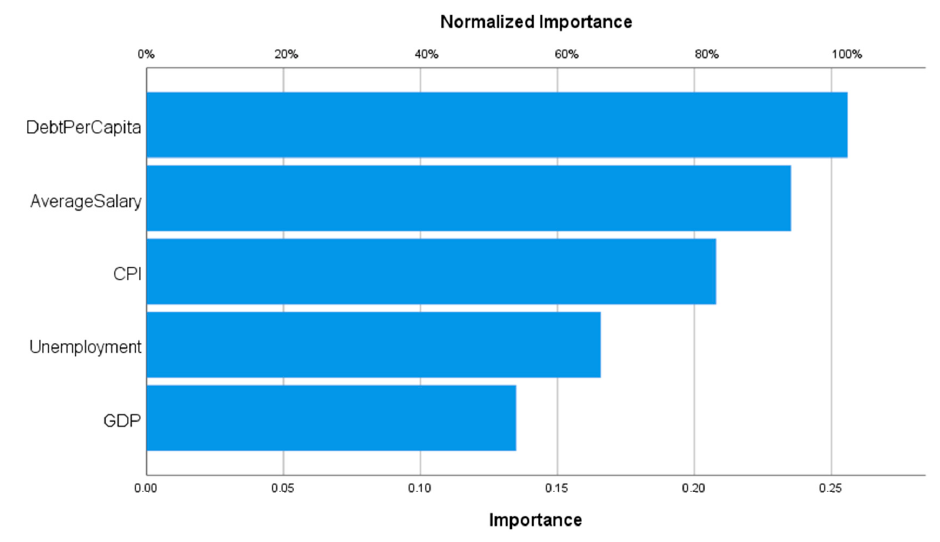
Figure 3. Standardized Importance of independent variables for Volume.